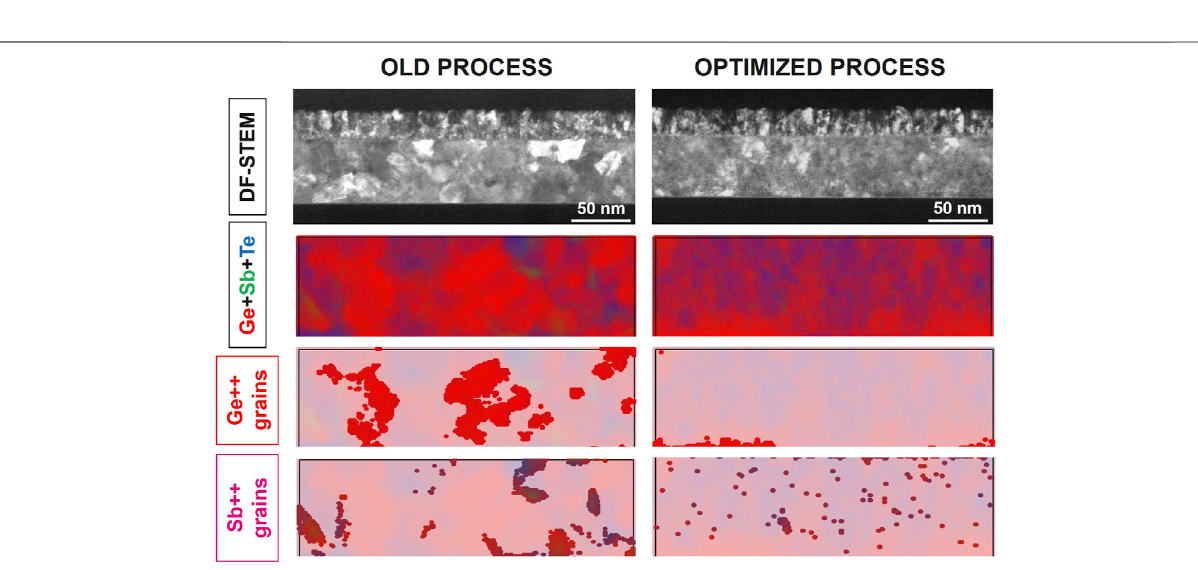
Frontiers in Physics |